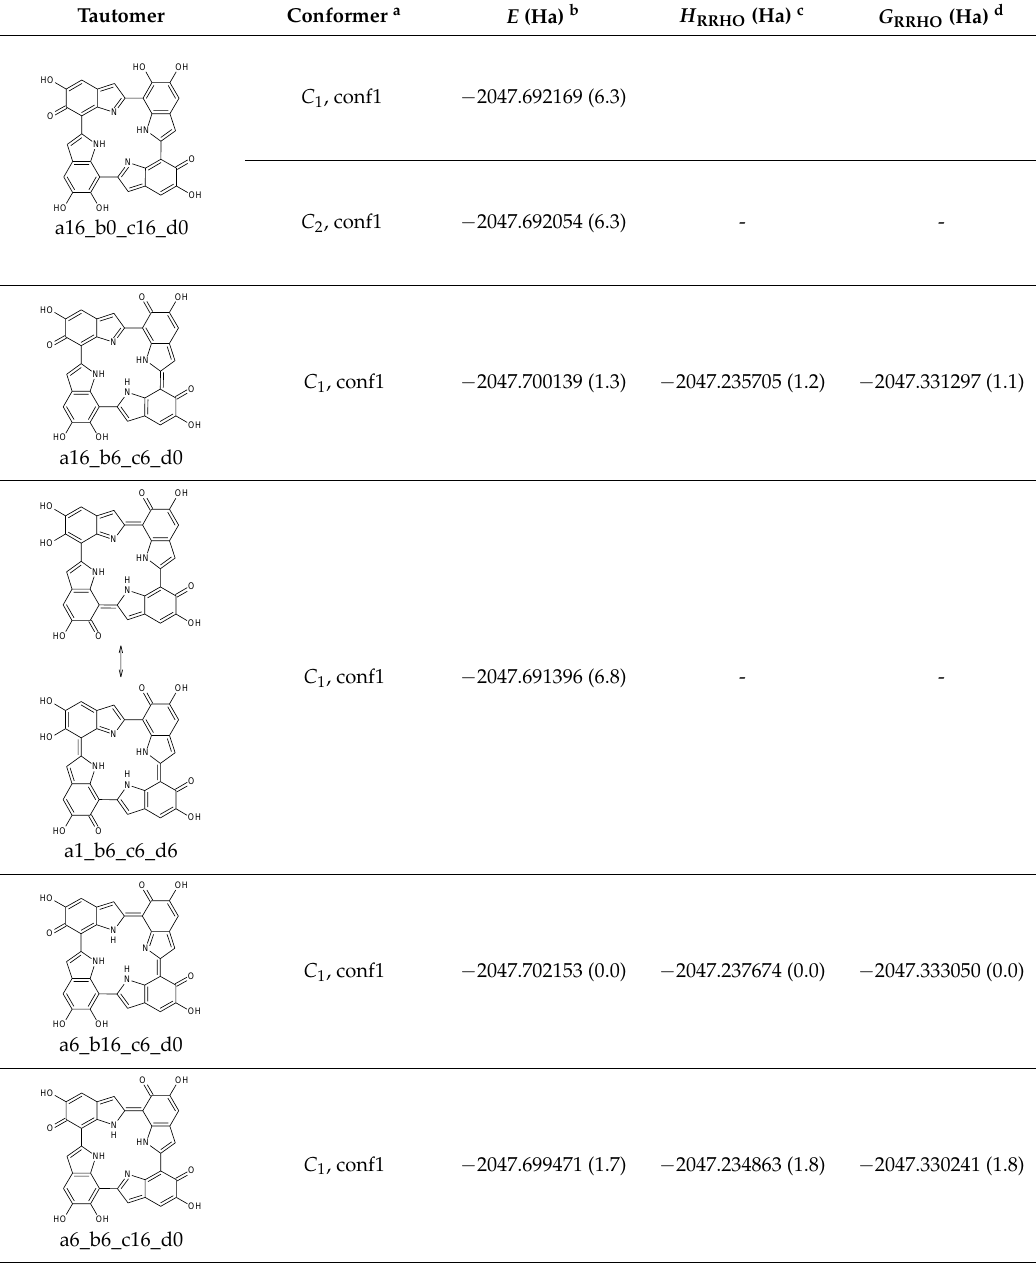
Table 10. KP-4e, neutral form in vacuo.